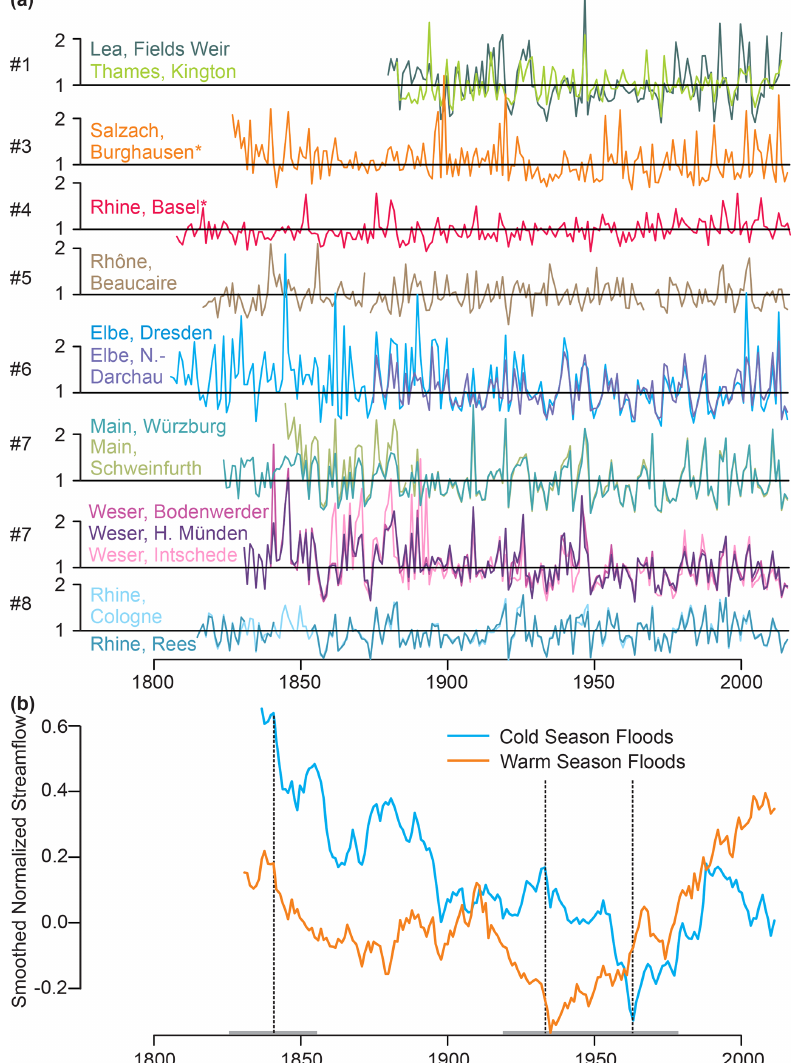
Figure 1. (a) Scaled series of annual peak streamflow for the 14 longest series in central Europe (Table S1, numbers on the left refer to the regions defined in Sect. 2.2). Stars denote streamflow series with predominantly summer floods. (b) Normalized series of annual peak streamflow averaged (50% of rivers must have data) for rivers with predominantly cold-season floods (blue) and warm-season floods (orange), smoothed with a 30-year moving average (min. 20 available years). Dashed lines with grey bars show the 30-year intervals chosen for